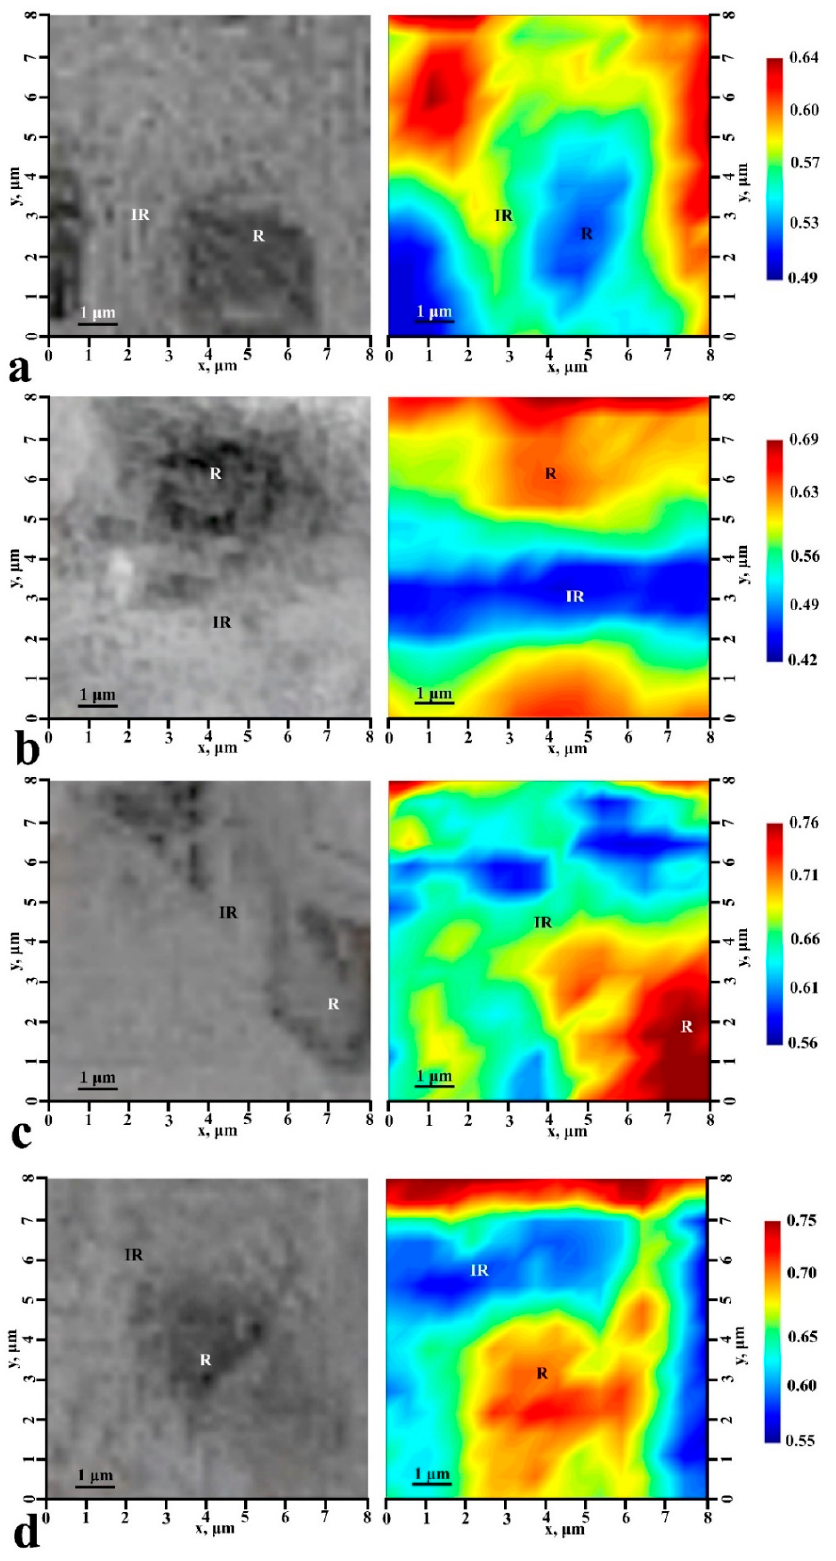
Figure 11. Optical (left) and chemical (right) images of the typical sample surface areas: ( a ) healthy tooth enamel without treatment (sample N1); ( b ) without pretreatment and with subsequent mineralization (sample N2); ( c ) after surface pretreatment with Са ( ОН ) 2 and subsequent mineralization (sample N4); ( d ) after surface pretreatment with Са ( ОН ) 2 and amino acid booster, with subsequent mineralization (sample N5).